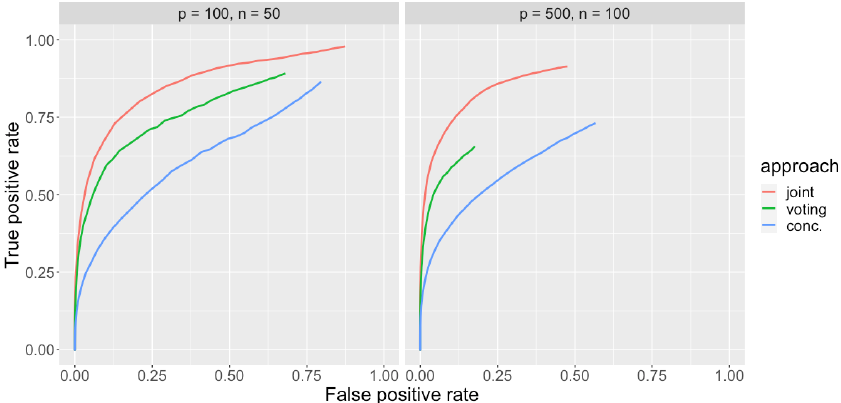
Figure 3. ROC curve for different approaches of inferring the graph from K = 3 datasets: joint estimation, voting and concatenation (denoted in different colors). Left panel : performance for p = 100, n k = 50 ∀ k . Right panel : performance for p = 500, n k = 100 ∀ k